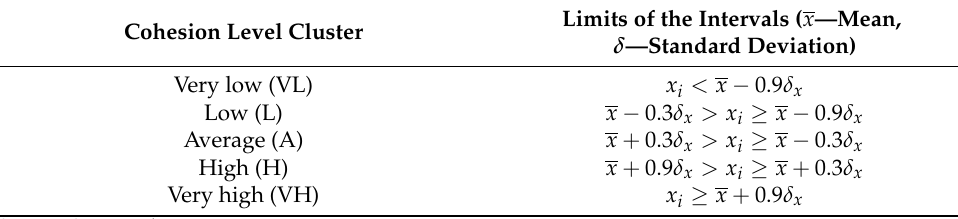
Table 1. Cluster intervals of the Cohesion Index (CI) synthetic variable. Cohesion Level Cluster